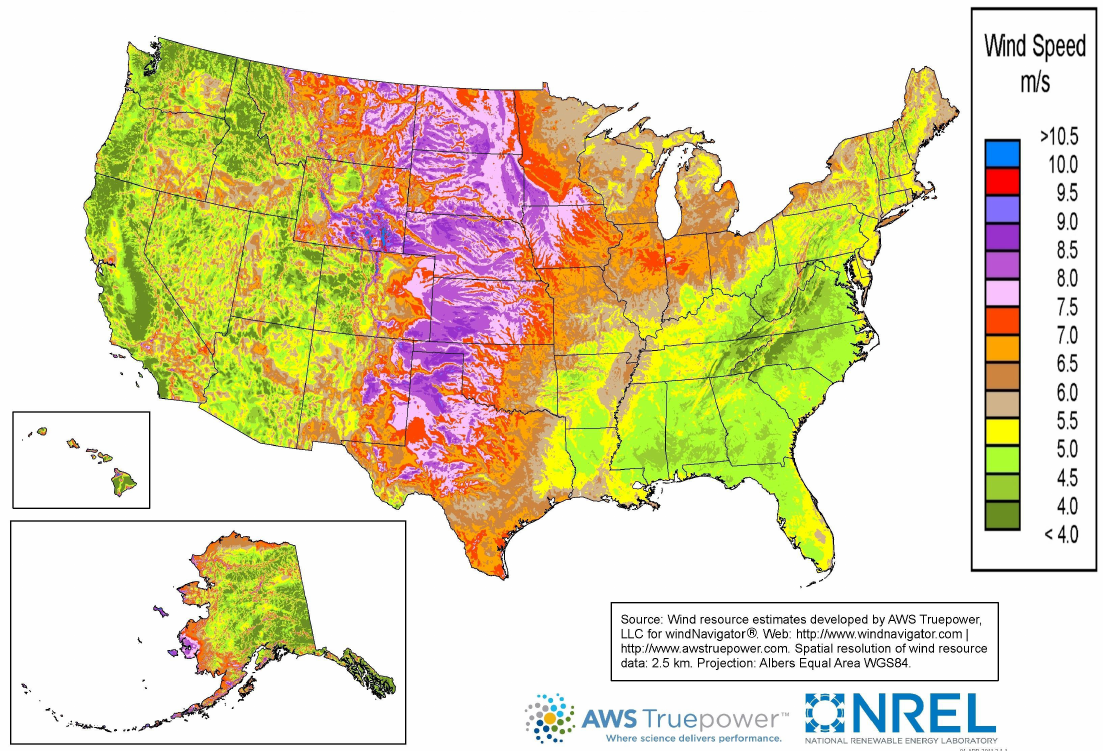
Figure 1. Annual average wind speed of the US at 80 m